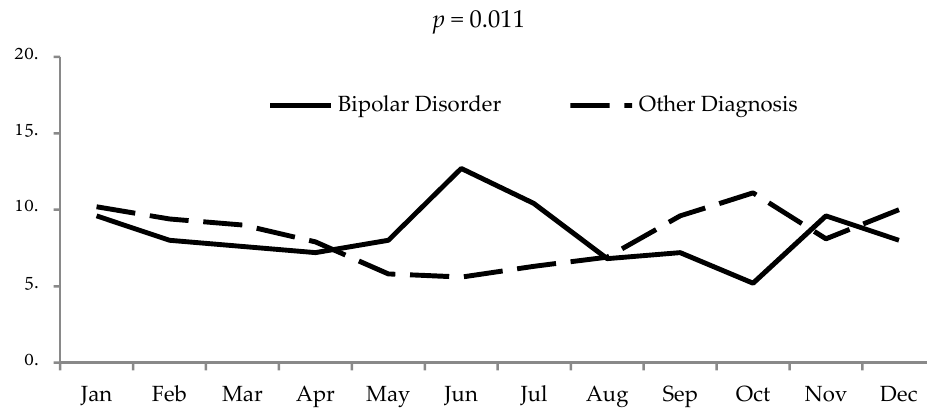
Figure 1. Inpatient admission rates by month: comparison between bipolar and other mental disorders (adapted by Aguglia et al., 2018) [16].